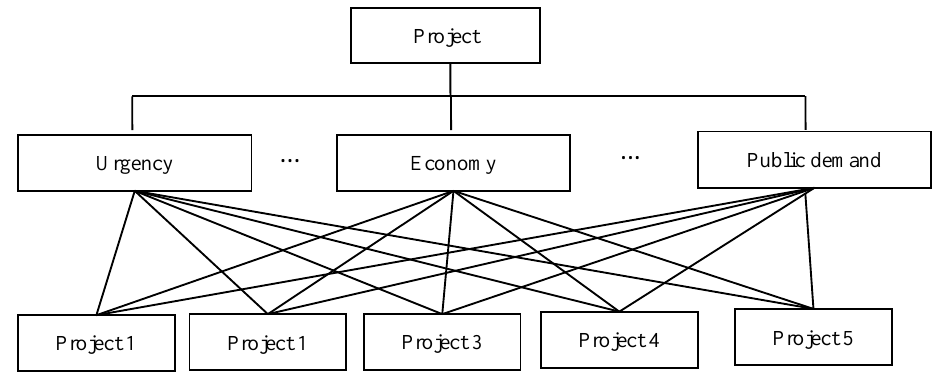
Figure 2. AHP for project selection.